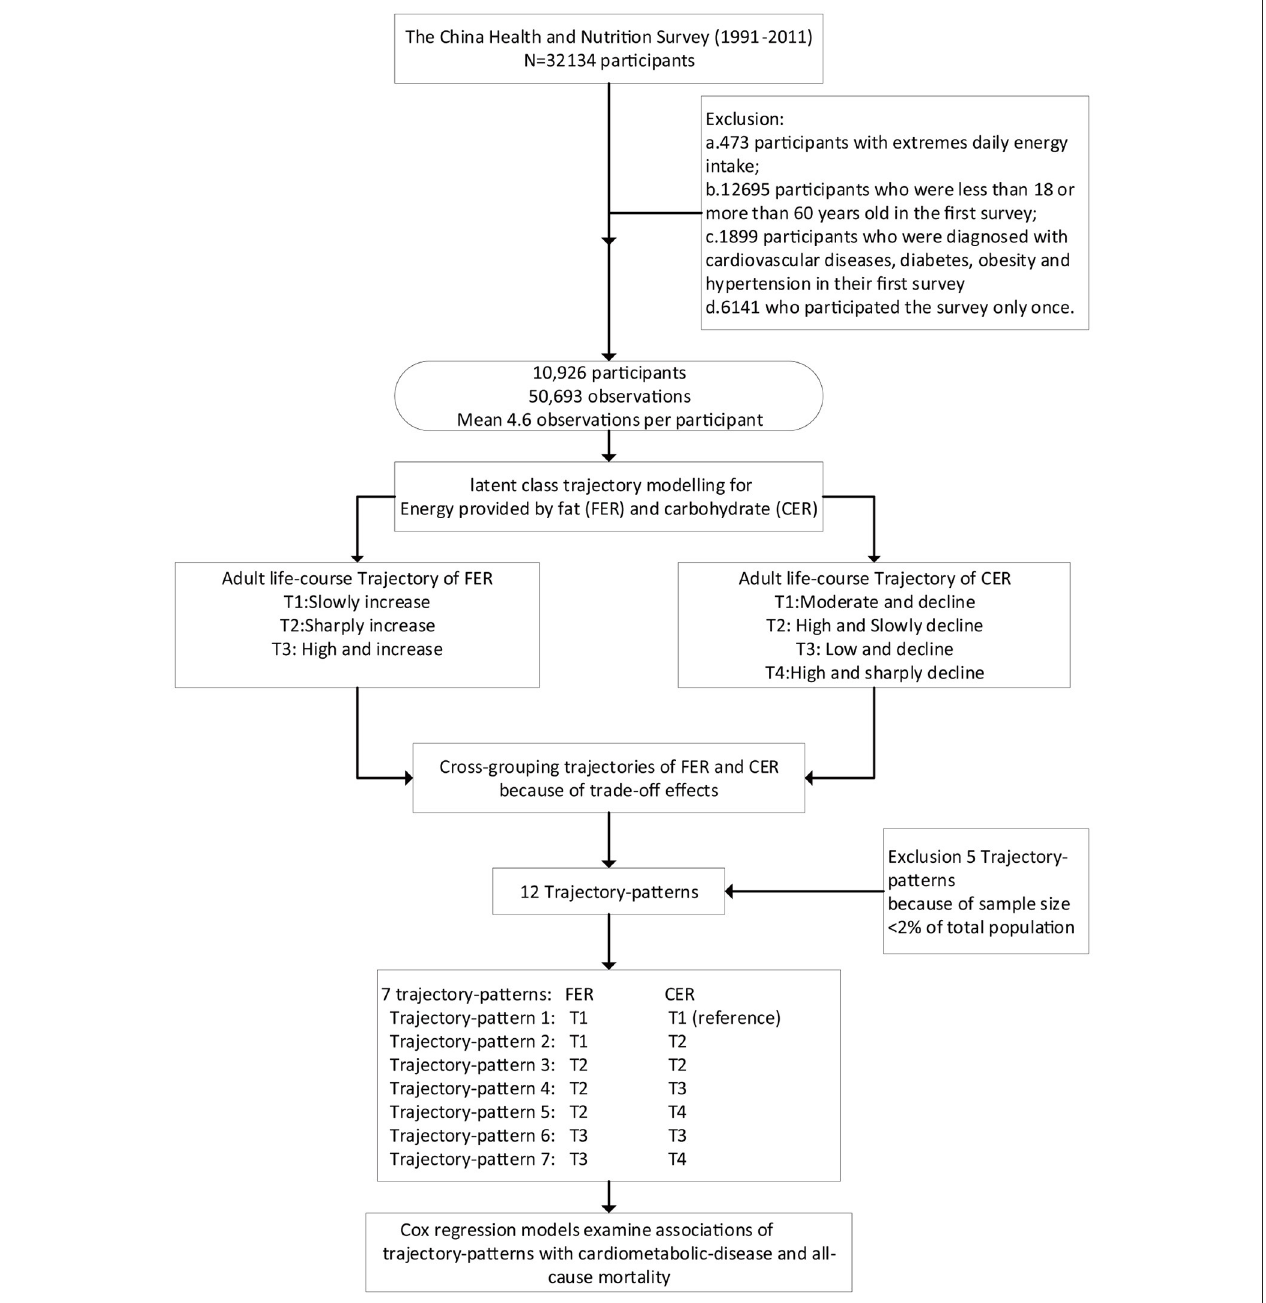
FIGURE 1 | Flow paradigm for this